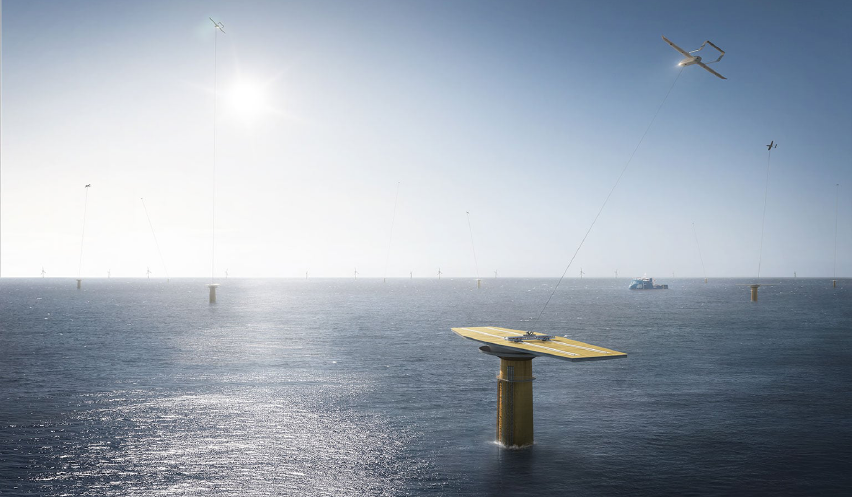
Figure 13. A rendering of an offshore wind farm for future AWES with ElektRail launch and land- ing